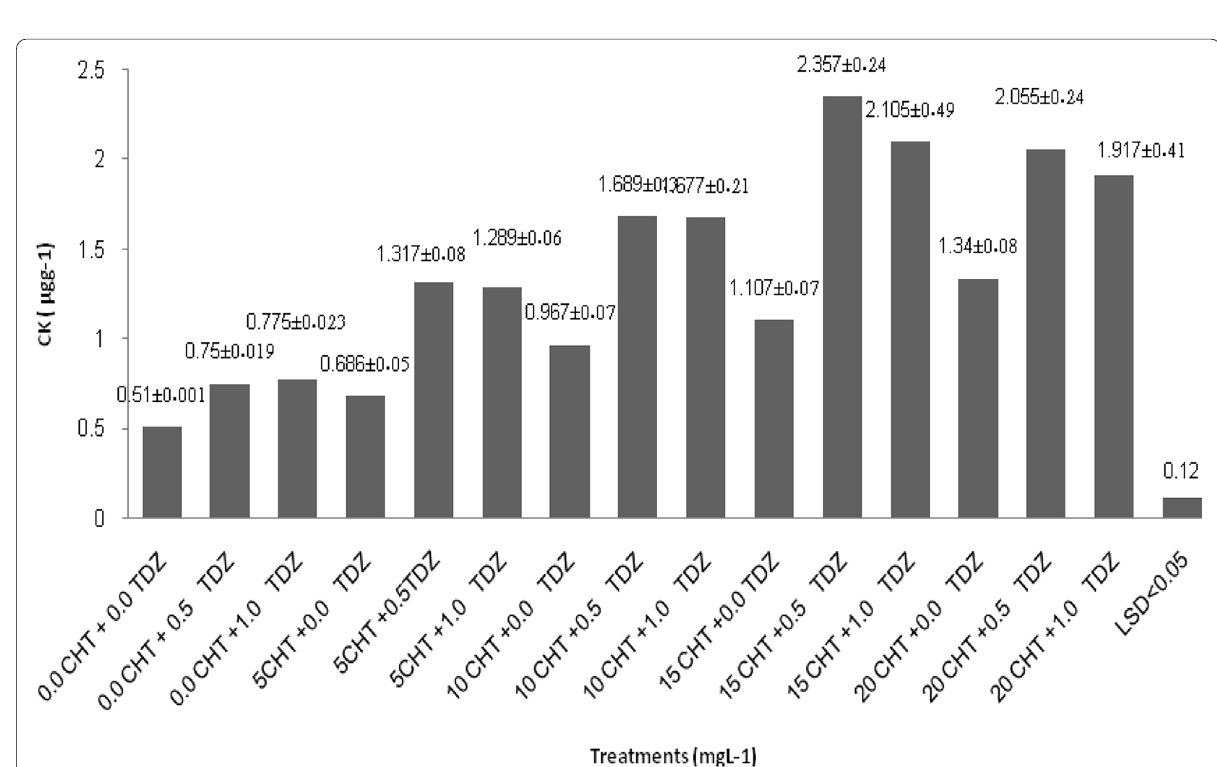
Fig. 4 Effect of chitosan (CHT) and thidiazuron (TDZ) on endogenous cytokinin (CK) content.